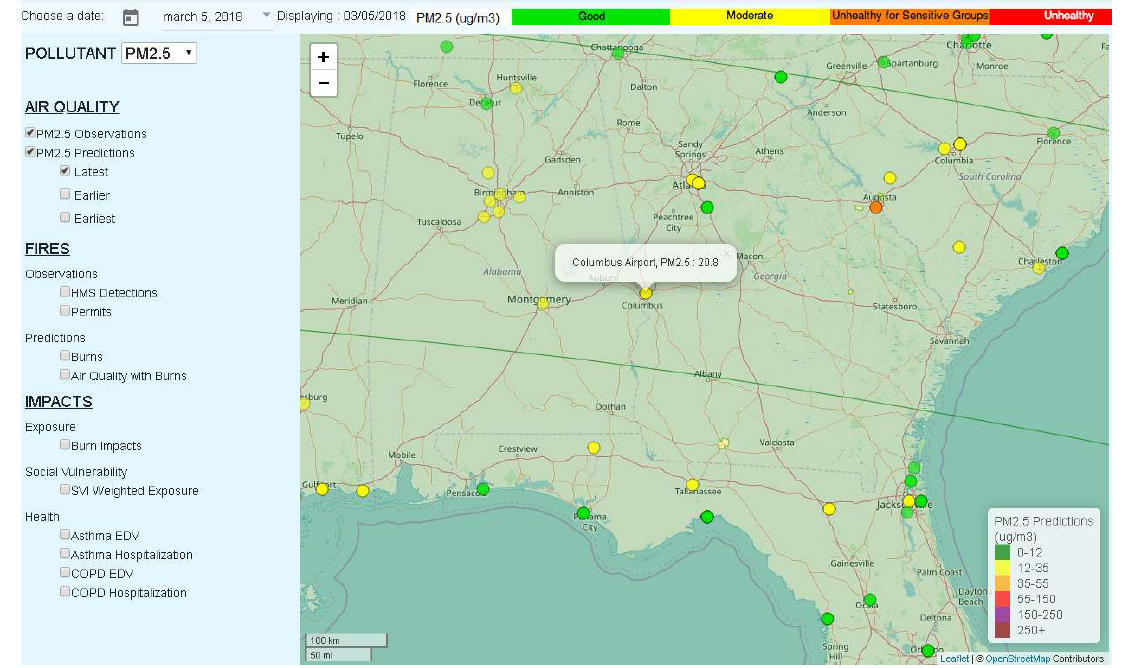
Figure 2. PM 2.5 observations and HiRes2 forecasts at the Columbus Airport site, and in the region surrounding Columbus, Georgia, on 5 March 2018.